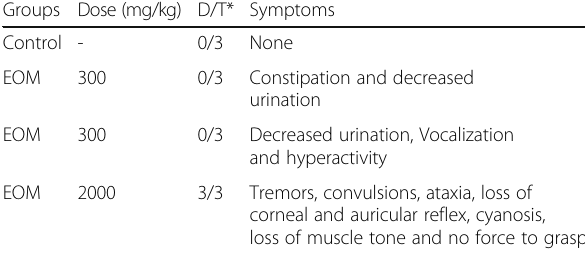
Table 2 Effect of single doses (i.p.) of EOM in mice ( n =3)